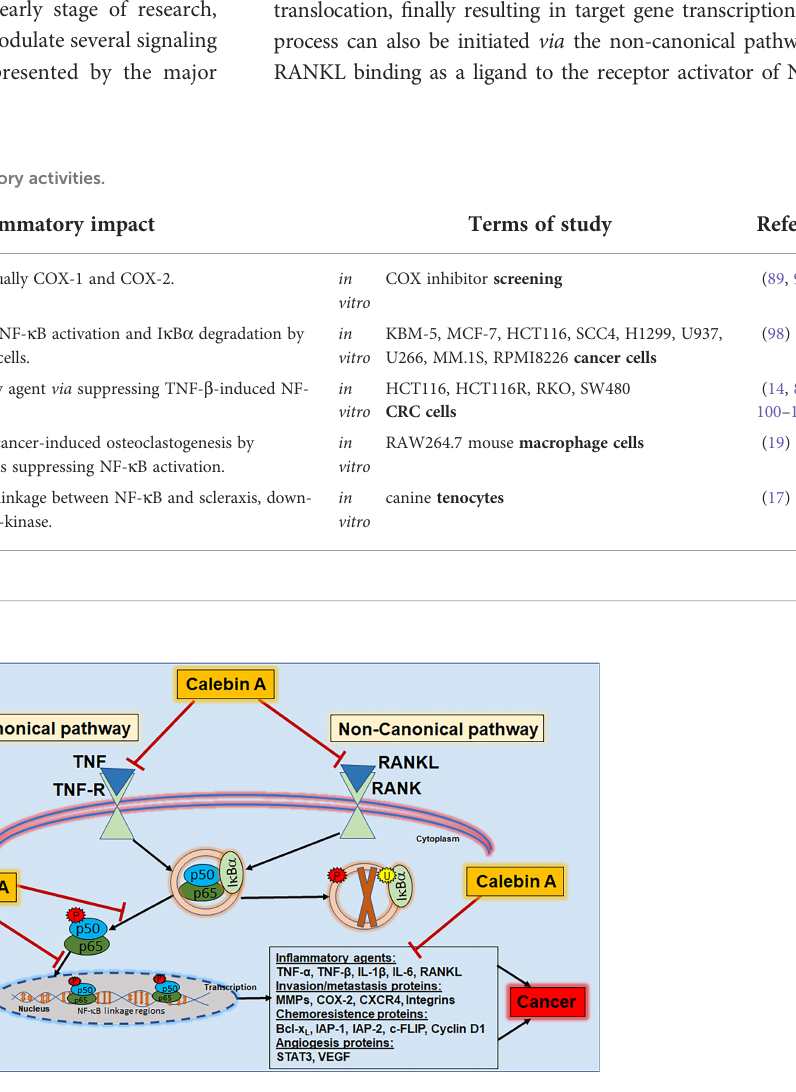
FIGURE 3 Calebin A as anti-in fl ammatory pathway modulator. Calebin A modulates the NF- k B cascade via both the canonical and non-canonical pathways and can therefore be useful in the prevention or co-treatment of in fl ammation, chronic diseases or cancers. TNF, tumor necrosis factor; TNF-R, tumor necrosis factor receptor; RANK, receptor activator of NF- k B; RANKL, receptor activator of NF- k B ligand; I k B, inhibitor nuclear factor of kappa light poly-peptide gene enhancer in B-cells; NF- k B, nuclear factor kappa-light-chain-enhancer of activated B-cells; IL, interleukin; MMP, matrix metalloproteinase; COX-2, cyclooxygenase-2; CXCR4, C-X-C chemokine receptor type 4; Bcl-xL, B-cell lymphoma-extra-large; IAP - inhibitor of apoptosis protein; STAT3, signal transducer and activator of transcription 3; VEGF, vascular endothelial growth factor.